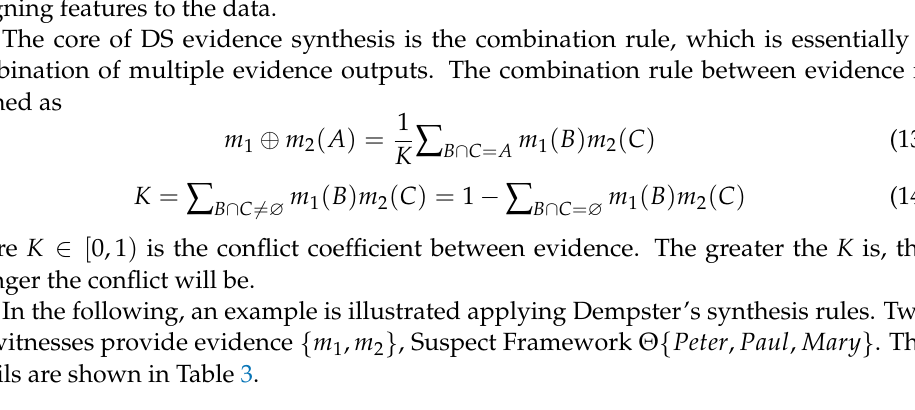
Table 3. Evidence of